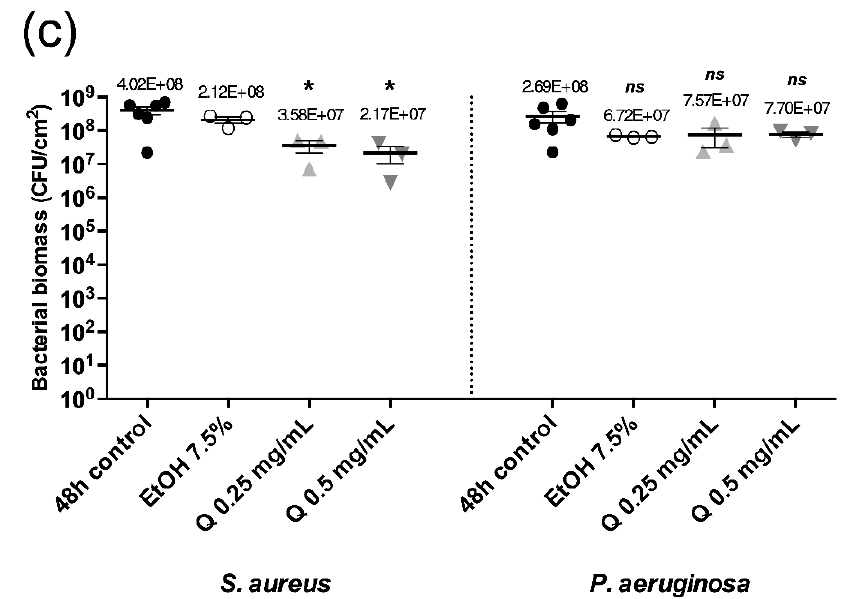
Figure 2. Bacterial biomass of S. aureus or P. aeruginosa mono-species mature biofilms after 24 h contact at 37 ◦ C with solutions of G ( a ), K ( b ) and Q ( c ) at concentrations indicated. Error bars represent the standard error of the mean for at least three replicates. Statistically significant differences with 48 h control are marked with asterisks: * p ≤ 0.05, ** p ≤ 0.01, *** p ≤ 0.001 and **** p ≤ 0.0001